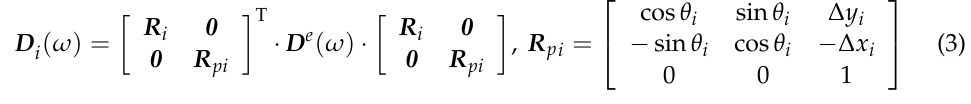
Table 1. Orientation angle of flexure hinges/beams with respect to the reference coordinate frame. Variables Values Variables Values Variables